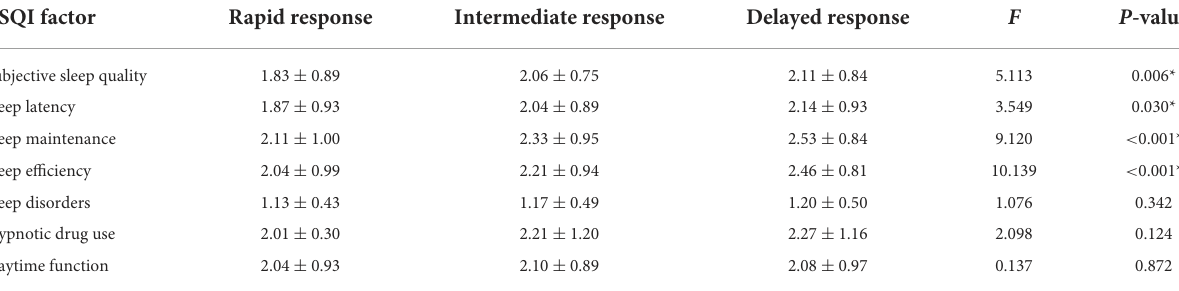
TABLE 3 PSQI factors scores of insomnia patients in the three groups at baseline (mean ± SD).